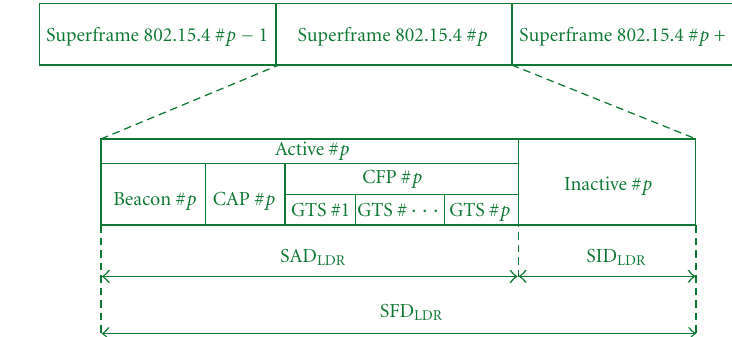
Figure 3: IEEE 802.15.4 MAC superframe structure.